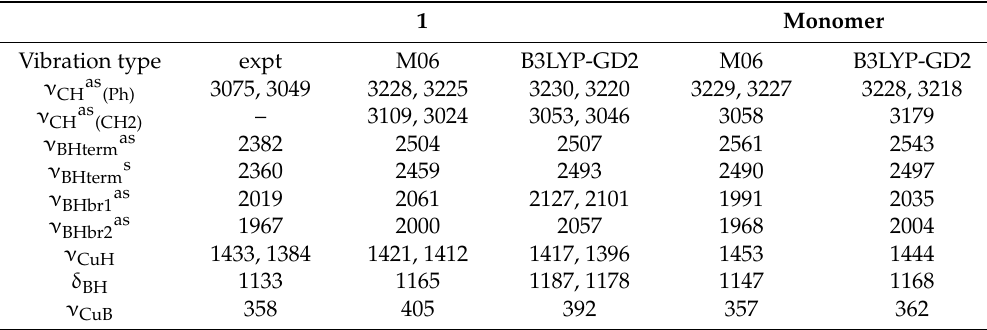
Table 5. Experimental and the calculated values of IR-active vibration bands for crystal structure 1 and optimized structures.